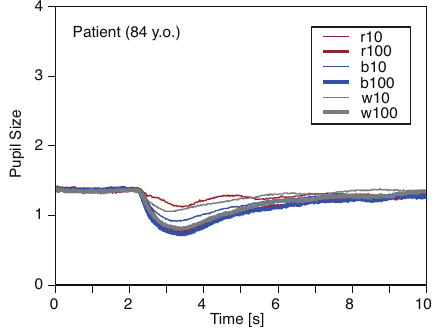
Patient (84 y.o.) r10